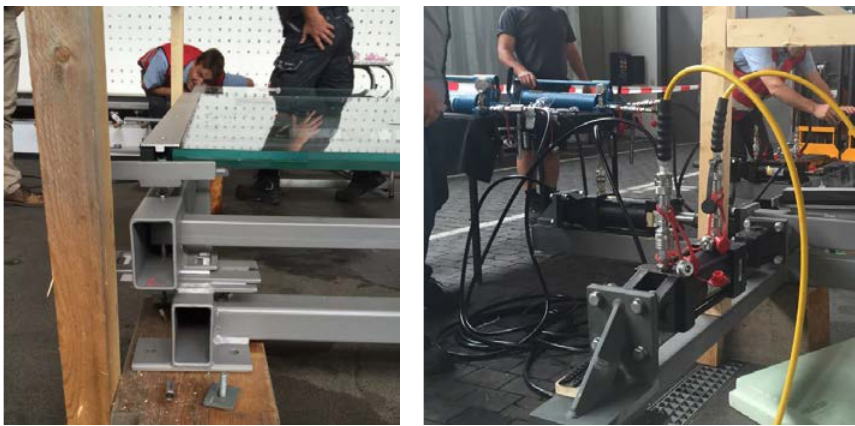
Figs. 18, 19 Principle of rhombic distortion, differential movement in north-south and east-west direction (left); analysis of dome distortion effects (right). Graphic: Knippers Helbig